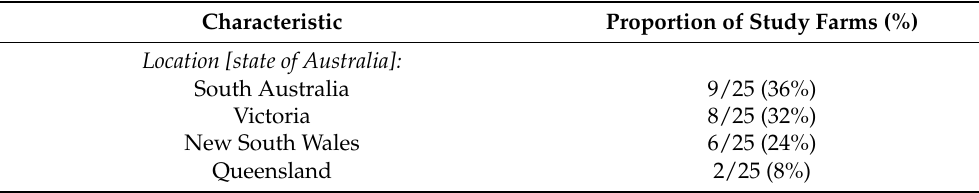
Table A2. Characteristics of the 25 pig farms